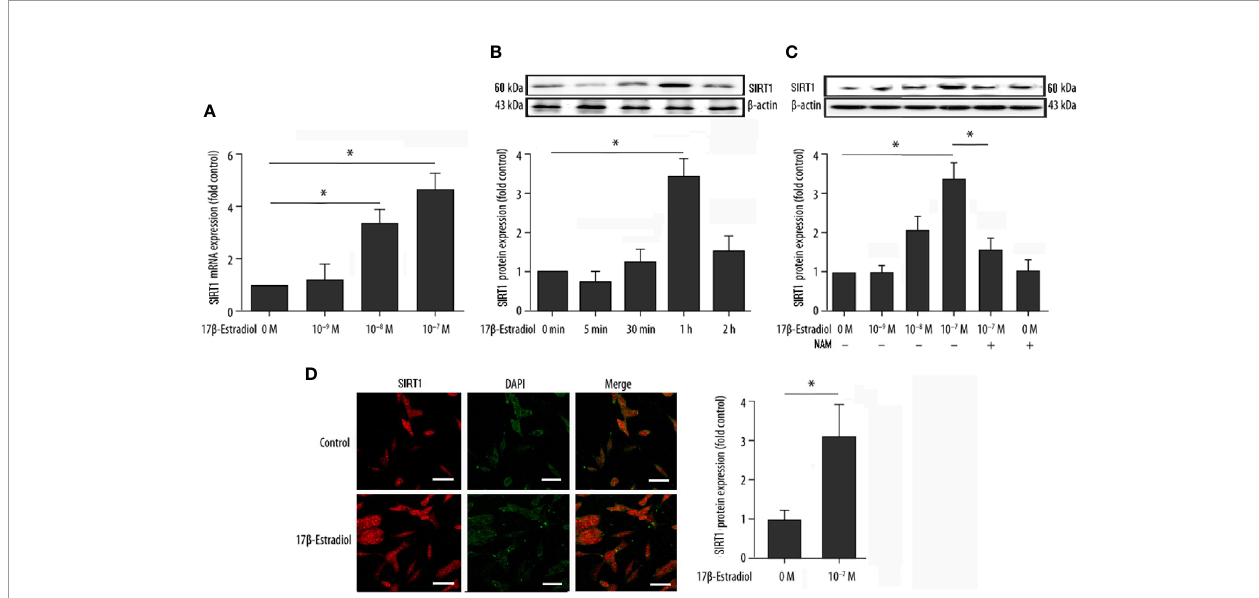
FIGURE 1 | 17 b -Estradiol (17 b -E2) elevated the expression level of SIRT1 in ATDC5 chondrocytes. (A) Effect of 17 b -E2 on the SIRT1 mRNA expression level in ATDC5 chondrocytes; RT-PCR was performed to demonstrate the expression of SIRT1 mRNA. Results were normalized to GAPDH mRNA. (B) Serum-starved ATDC5 chondrocytes were treated with 17 b -E2 (1 × 10 -7 M) for the indicated time (0, 5, 30, 60, and 120 min), and Western blot analysis was applied to show the expression level of SIRT1 protein. (C) Serum-starved ATDC5 chondrocytes were pretreated with or without 15 m M NAM for 30 min, followed by treatment with incremental concentrations of 17 b -E2 (0 M, 1 × 10 -9 M, 1 × 10 -8 M, and 1 × 10 -7 M). Western blot analysis was performed to demonstrate the expression of SIRT1 protein. b -actin was used as an internal control. (D) Confocal immuno fl uorescence (IF) staining of ATDC5 chondrocytes stained for SIRT1 (red). 4 ’ , 6-diamidino-2- phenylindole (DAPI [blue]) was applied to stain the nucleus. The intensity of SIRT1 was higher in ATDC5 chondrocytes cultured in serum-free medium, which contained 17 b -E2. The whole experimental process is described in the Materials and Methods section. These experiments were independently repeated 3 times. * P < 0.05 versus the control group indicated a signi fi cant